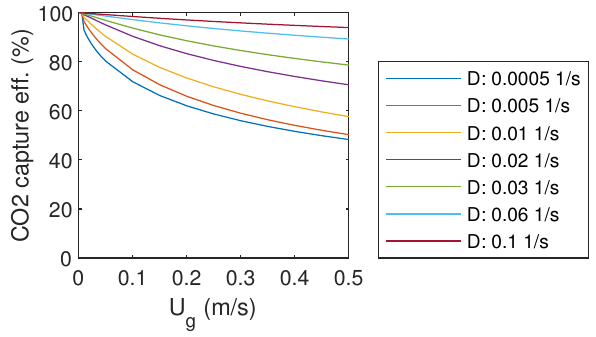
Figure 3. CO 2 capture